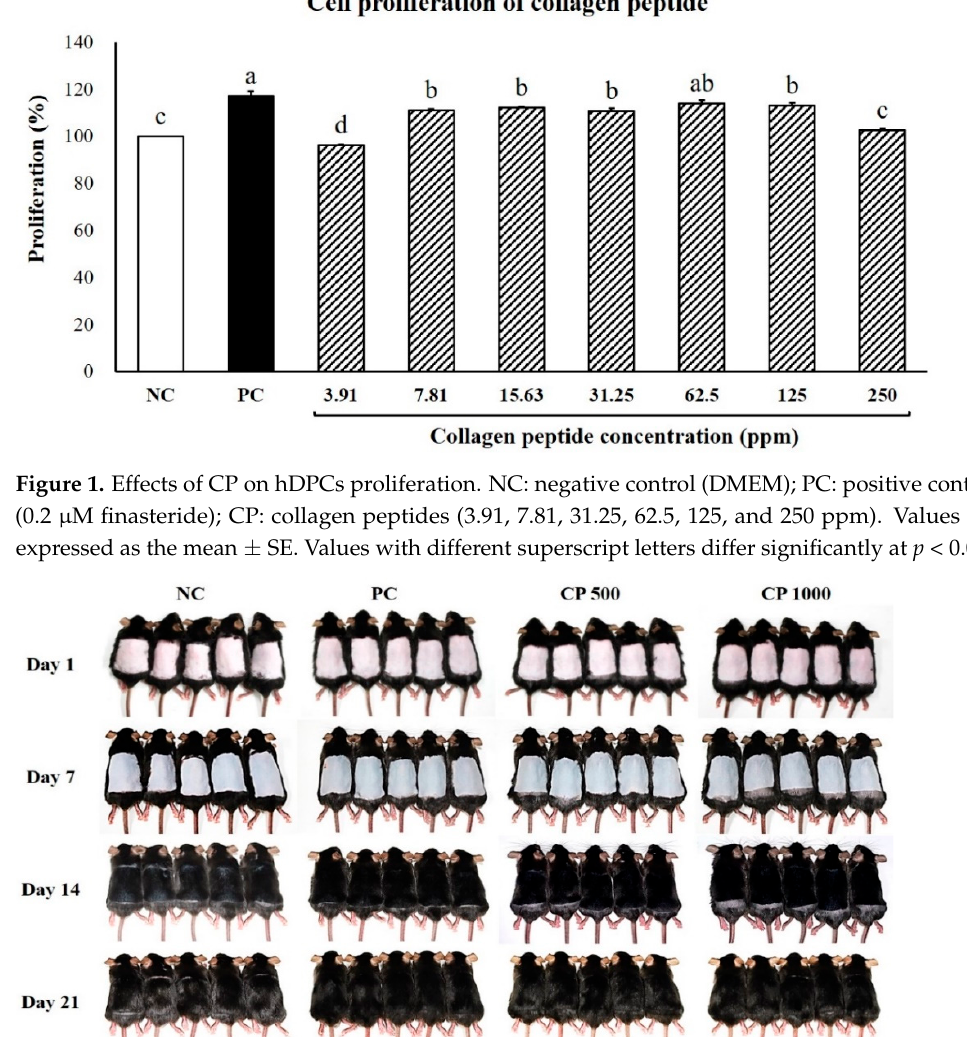
Figure 1. Effects of CP on hDPCs proliferation. NC: negative control (DMEM); PC: positive control (0.2 μ M finasteride); CP: collagen peptides (3.91, 7.81, 31.25, 62.5, 125, and 250 ppm). Values are expressed as the mean ± SE. Values with different superscript letters differ significantly at p < 0.05.